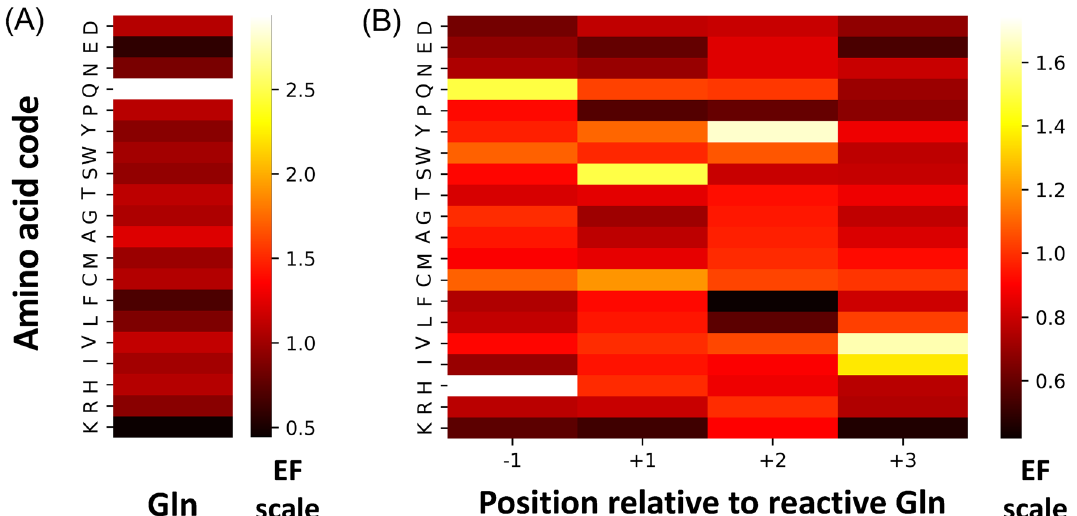
Figure 2. The heatmaps showing the color-coded enrichment factor of each amino acid at randomized positions of ( A ) LibQ and ( B )